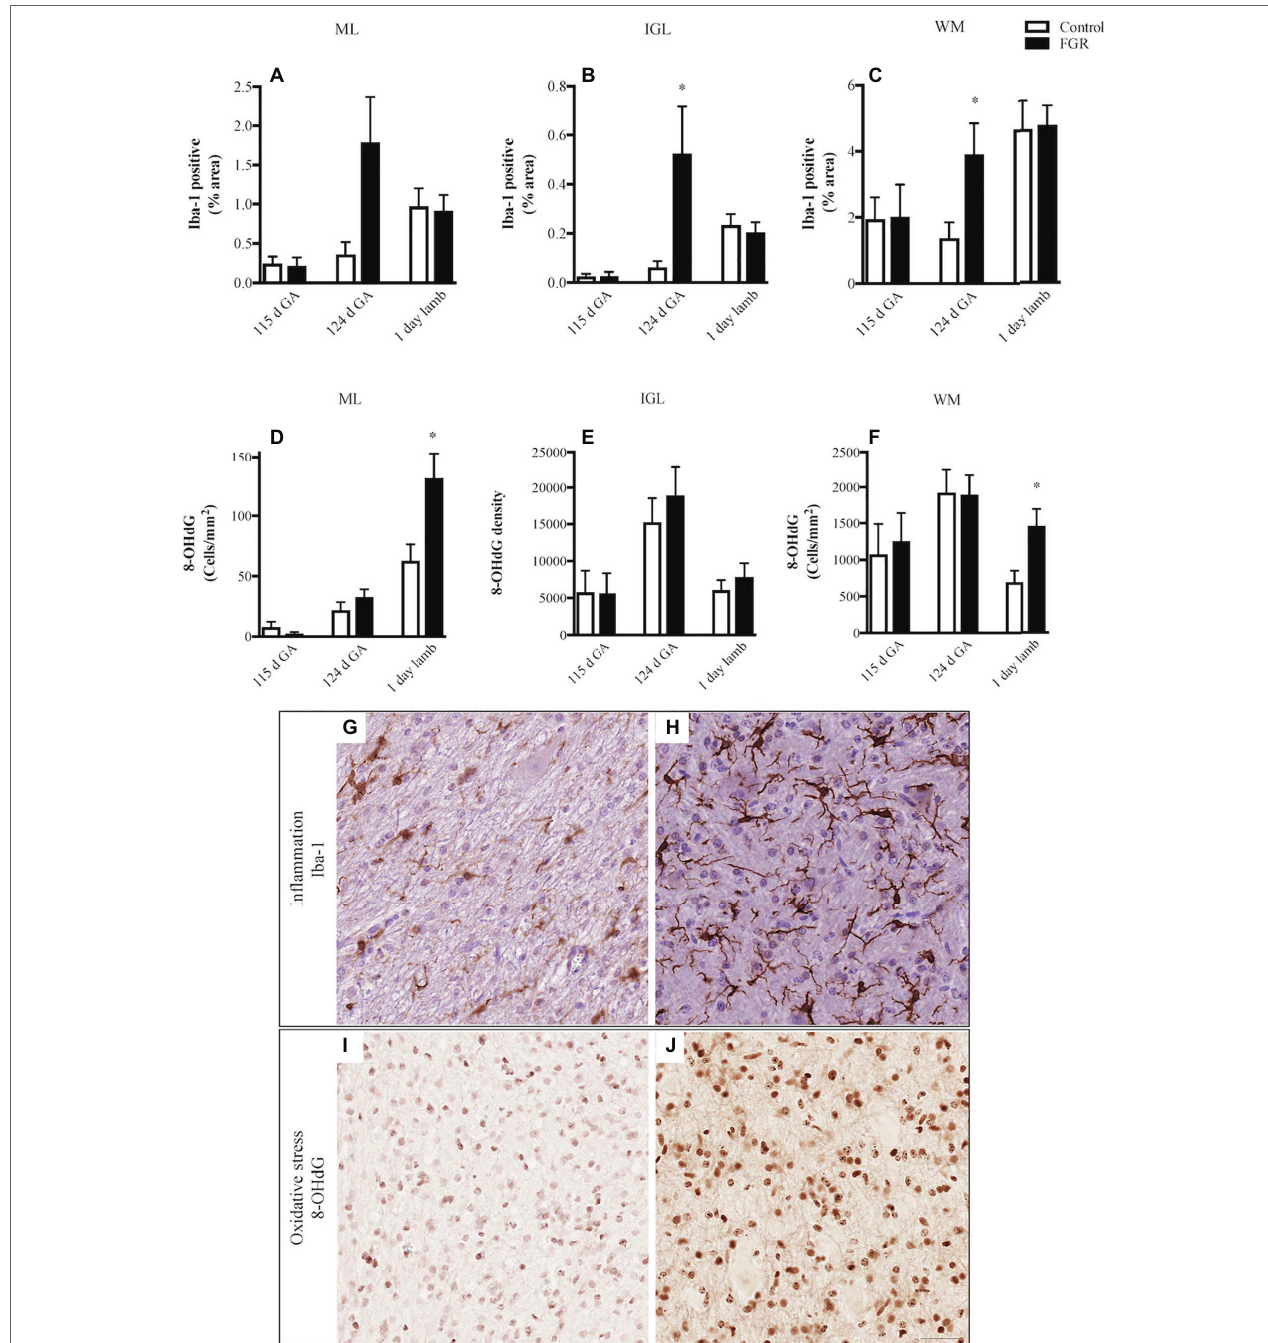
FIGURE 4 | The number of Iba-1-positive cells (A–C) and 8-hydroxy-2-deoxyguanosine (8-OHdG)-positive cells (D–F) in the molecular layer (ML), internal granular layer (IGL), and white matter (WM) in the fetal brain at 115 d GA, 124 d GA, and 1-day-old lamb of control and FGR animals. Each bar represents the mean ± SEM; * p ≤ 0.05 versus control. Representative micrographs showing Iba-1- (G,H) and 8-OHdG- (I,J) positive immunoreactivity in the WM in 124 d GA (G,H) and 1-day-old lambs (I,J) . Images from control (G,I) and FGR (H,J) animals are shown. FGR, fetal growth restriction. Scale bar = 25